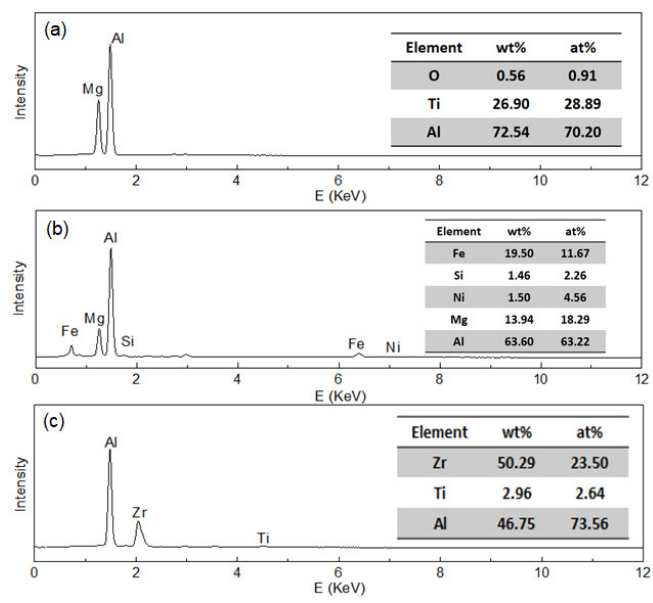
Figure 7. EDS results of 5A90 as-cast alloy in the SEM images. ( a ) Point A; ( b ) Point B; ( c ) Point C.